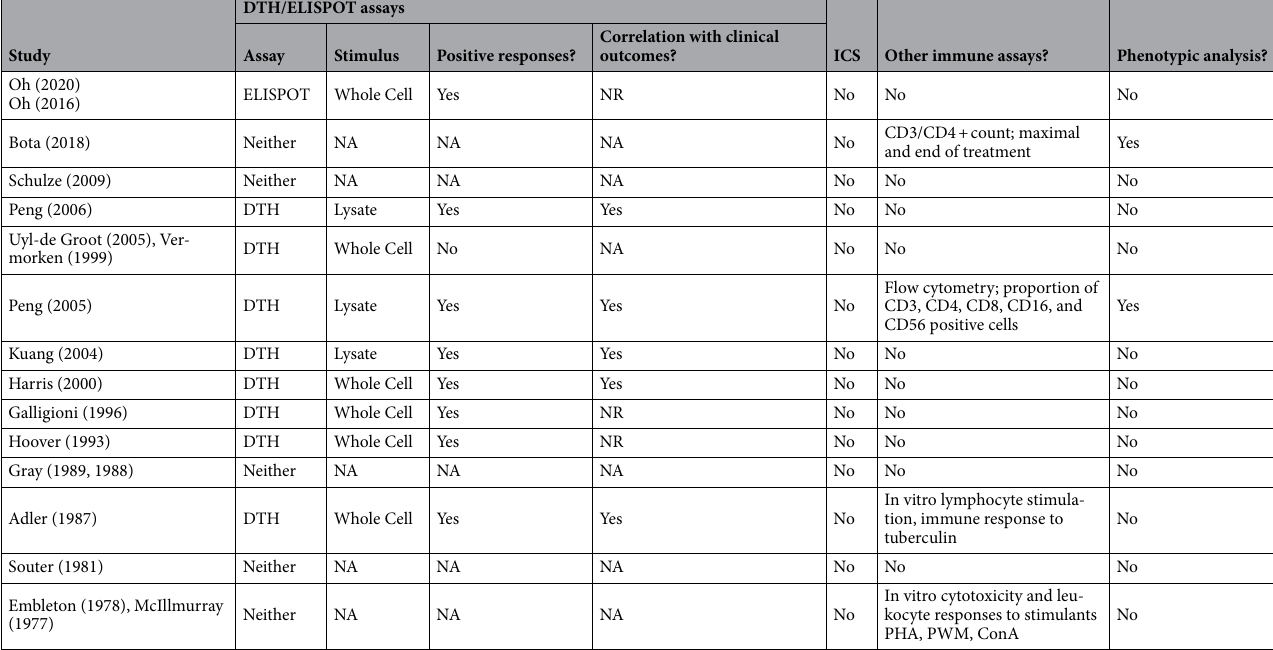
Table 4. Immune Assays. DTH delayed type hypersensitivity, ICS intracellular cytokine staining, ELISPOT enzyme linked immunospot, NR not reported, NA not applicable, PHA phytohaemagglutinin, PMW pokeweed mitogen, ConA concanavalin